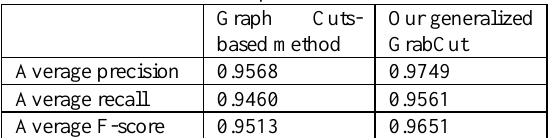
Figure 5. Tracking accuracy of the brown signboard.